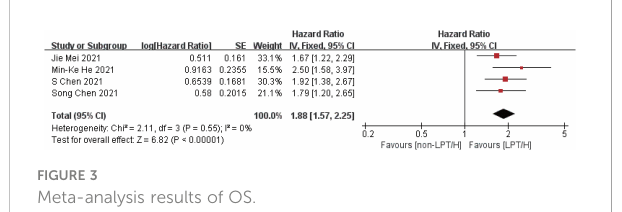
FIGURE 3 Meta-analysis results of OS.